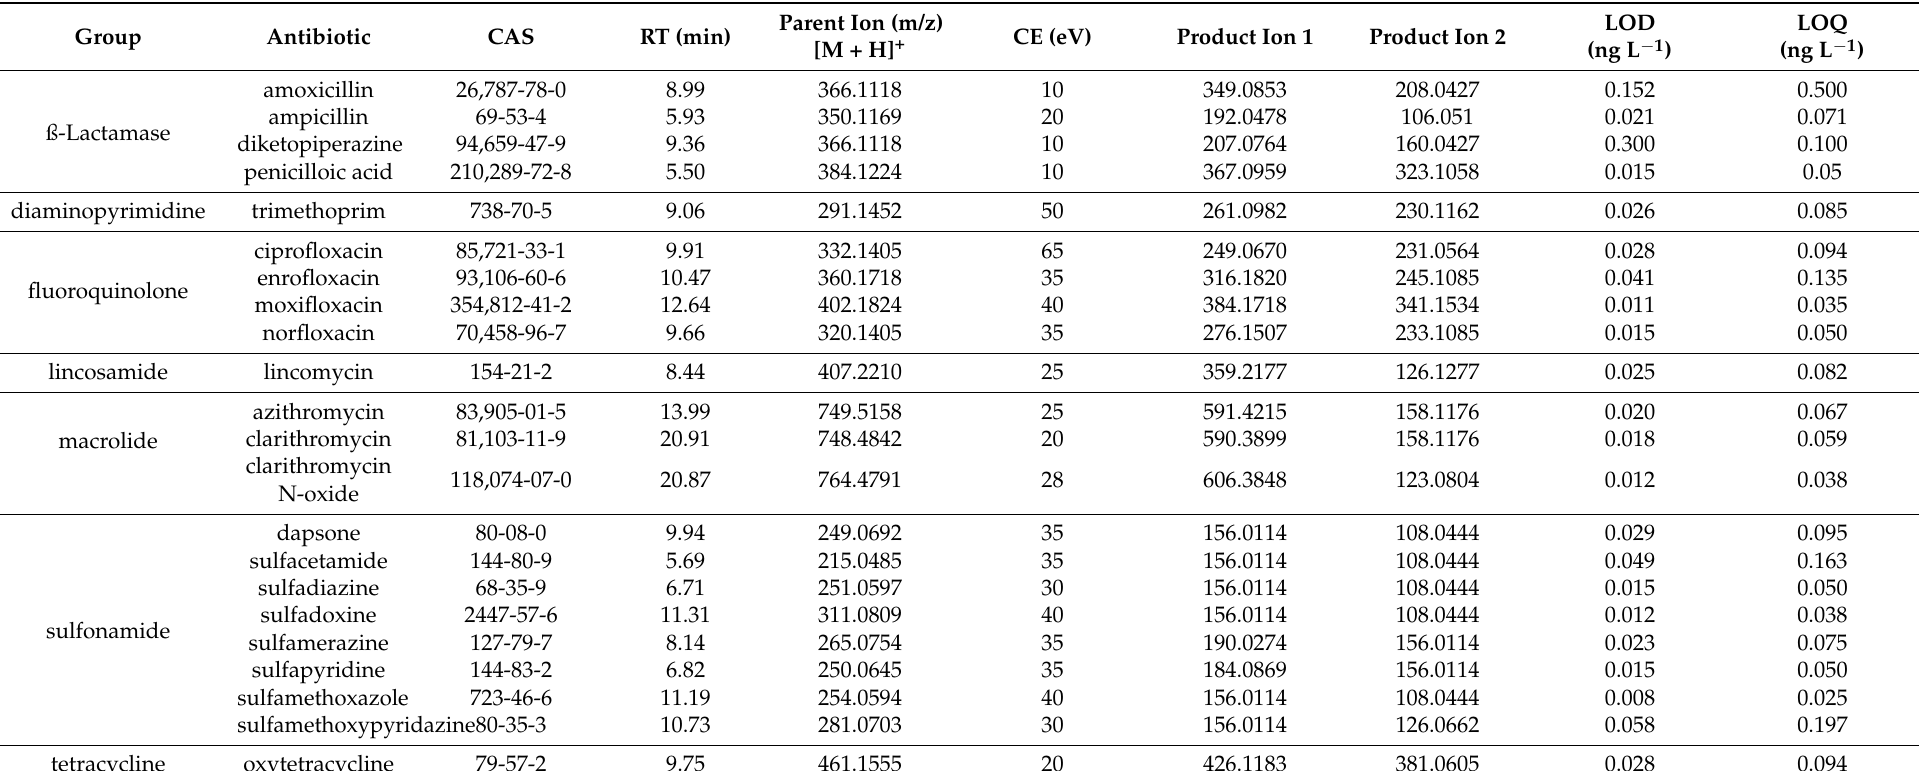
Table 1. MS detection parameters used in the quantitative analysis of the antibiotic